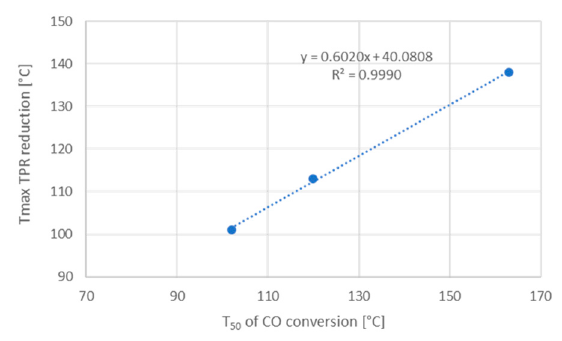
Figure 6. Correlation between T max reduction in TPR curves and T 50 of CO conversion in a stream containing 1 vol% CO + 1vol% O 2 in He.